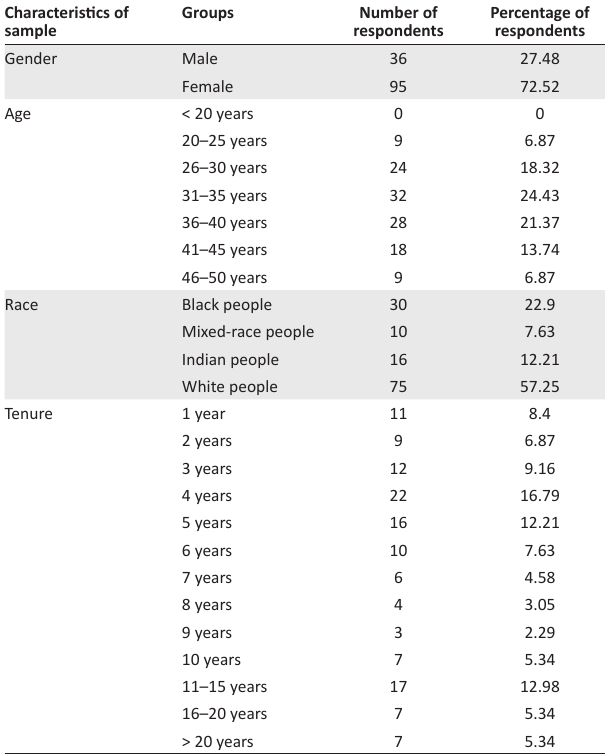
TABLE 1: Characteristics and biographical distribution of the